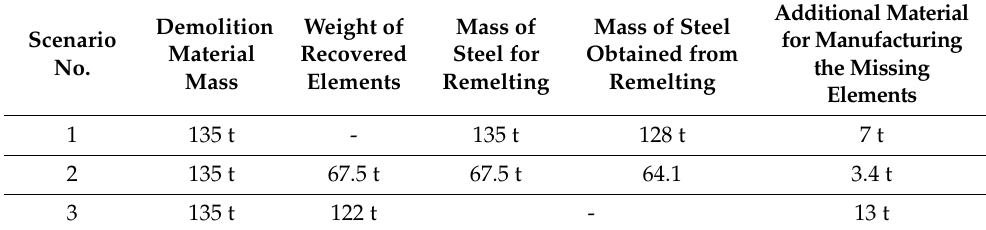
Figure 6. Scenario no. 2: Partial reuse of steel structure components and remelting the rest. Table 4. Material balance by